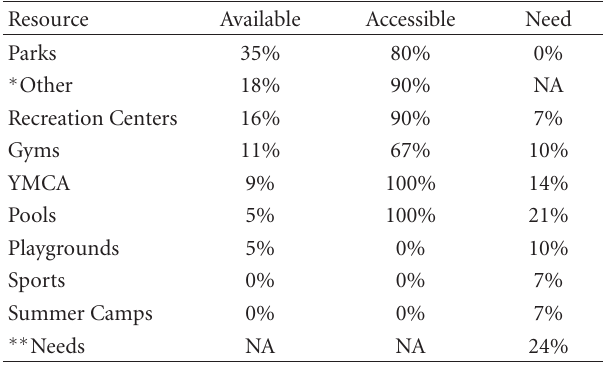
Table 6: Availability, accessibility and need of physical activity re- sources in the community.